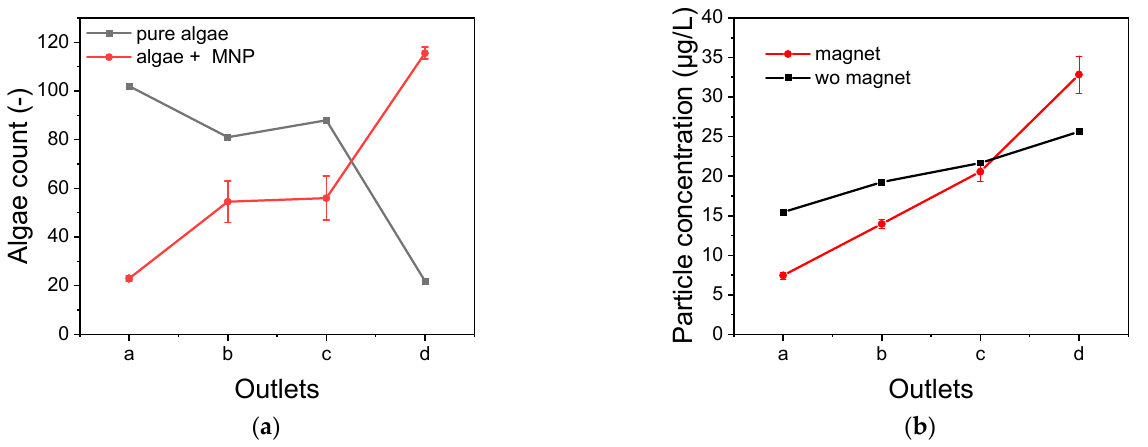
Figure 8. Separation process in millifluidic chamber 2. ( a ) Algae count from the Neubauer counting chamber for algae and mixtures of algae and magnetic nanoparticles. ( b ) Magnetic particle concentration determined with phenanthroline assay for separation with and without (wo) magnet.